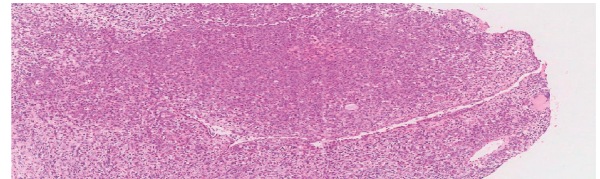
Figure 5: Microphotograph shows diffuse infiltration of large neoplastic lymphoid cells. HEx100x.